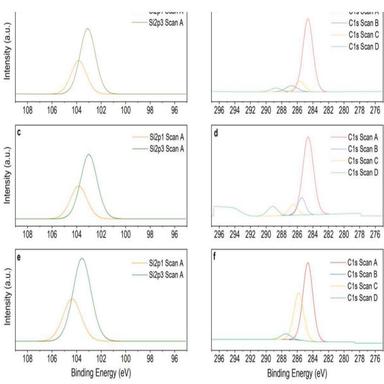
XPS spectra per element: Si-SCB (a), C-SCB (b), Si-CS (c), C-CS (d), Si-RH (e), and C-RH (f).